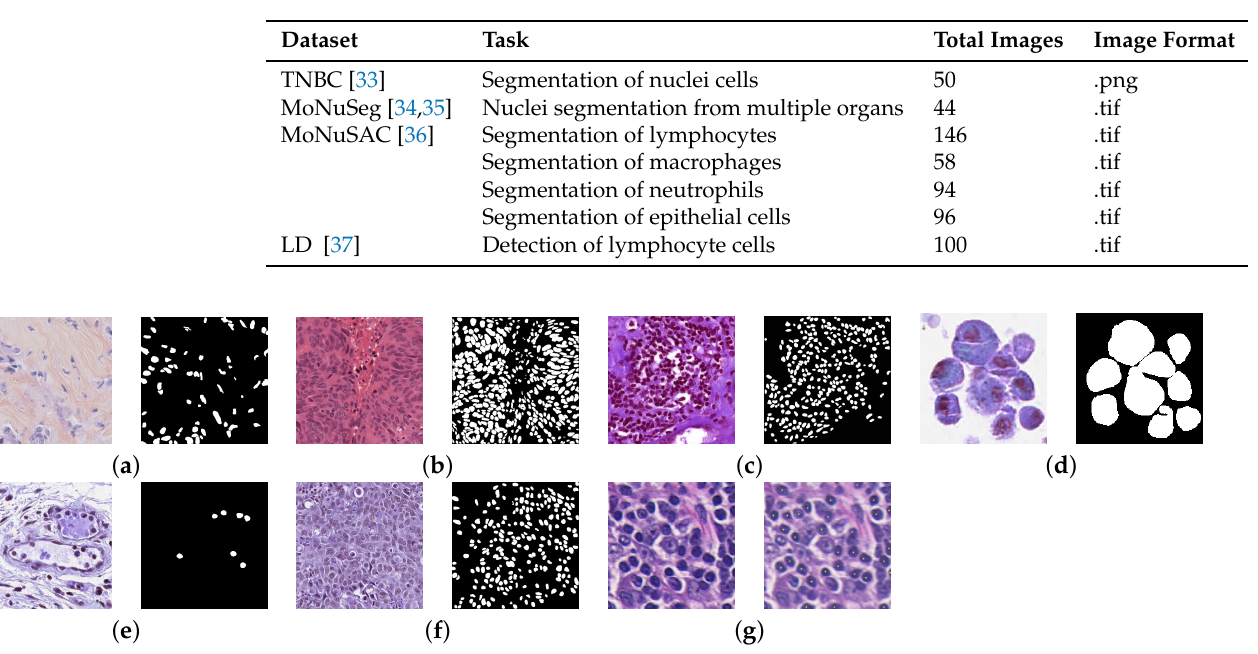
Table 2. Details of the datasets used in the work.